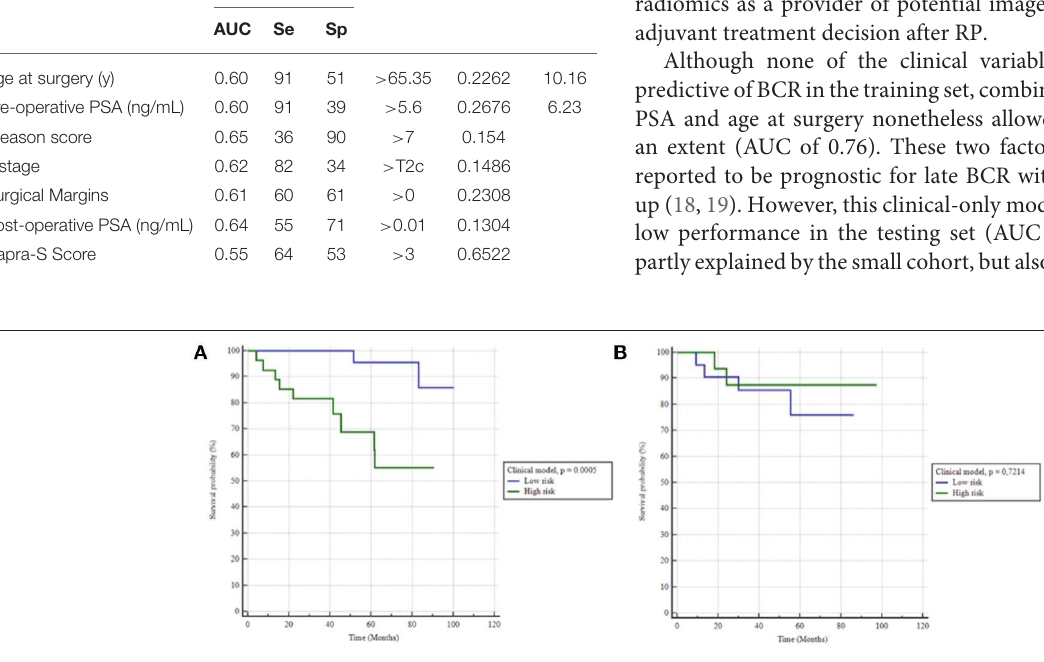
Frontiers in Oncology |